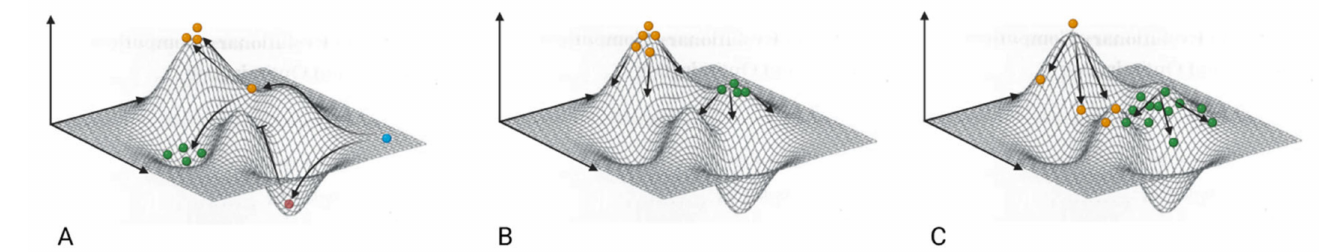
Figure 4. ( A ) The fitness landscape represents a relationship between genotype and evolutionary fitness. It allows the mutation to settle and thrive in the sequence space. Here, peaks and valleys represent high fitness due to the accumulation of specific mutations and low fitness due to minor fitness losses, respectively. A typical wild-type virus (represented as blue) that tries to occupy sequence space of the nearest peak by consecutive mutations will gain fitness and survive. At the same time, if it tries to occupy the sequence space of the valley, it will lead to the extinction of the mutant type (red). While in certain scenarios, mutations could lead to comparatively decreased fitness (green), so the virus is not extinct but incapable of proliferation. ( B ) In the above figure, mutants with low mutation rates are more stable (green) and cluster at the neighboring peaks, but the fittest will out compete the others. Mutants with high mutation rates will try to occupy neighboring peaks but, due to large mutational shifts, get trapped in the sequence space and will not spread out (yellow). ( C ) In order to achieve the highest peak, wild jumps are needed, which consequently leads to fitness and, therefore, the probability is low for their survival. On the other hand, mutants with slow and stable leaps are mutationally robust (green ones on comparatively flatter peaks) and will prevail. Therefore, the mutants on the higher peak (yellow) will always represent lower mean fitness in comparison to mutants on flatter peaks